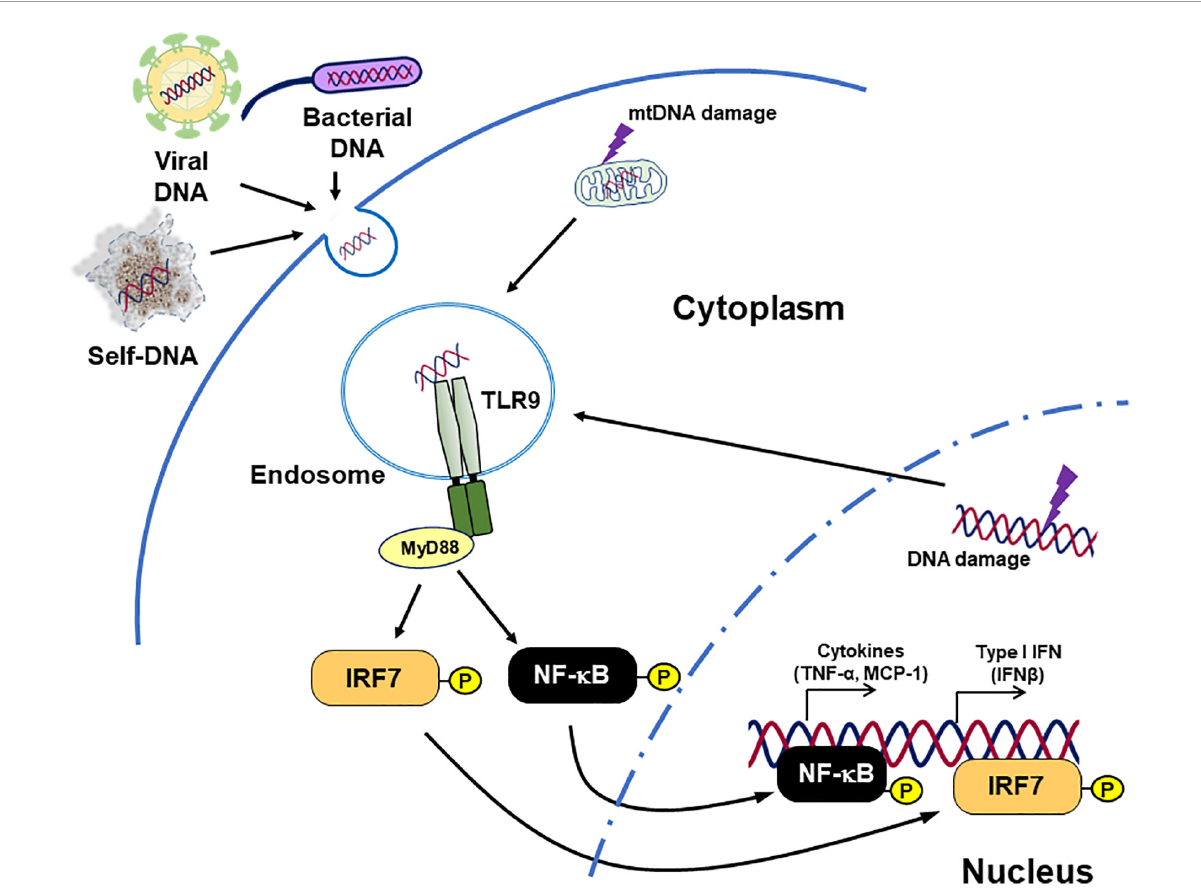
FIGURE1 Inflammation caused by TLR9. TLR9 binds not only DNA originating from bacteria and viruses but also endogenous DNA and triggers signaling cascades related to pro-inflammatory responses. Diseases such as cancer, chronic infection, and lifestyle-related diseases can modulate TLR9 expression. In addition, tissue damage caused by these diseases increases the release of TLR9 agonists. This figure is reproduced from Fukuda et al. (80) with